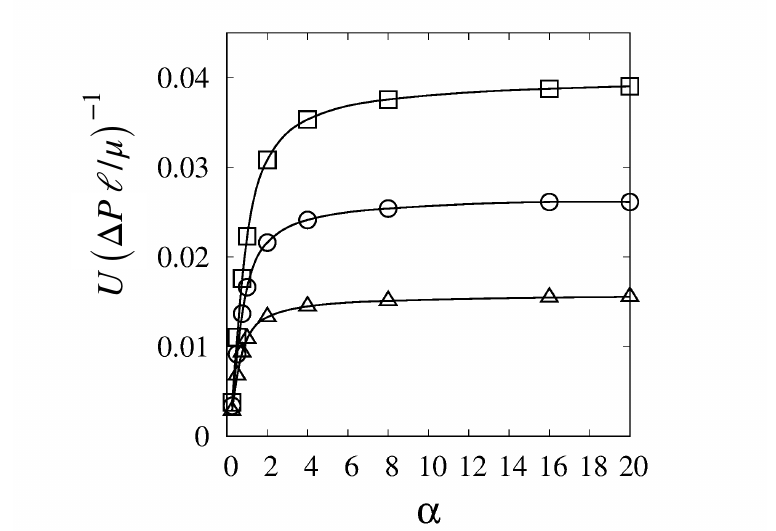
Figure 10. Dimensionless average velocity, vs the cell aspect ratio for different values of the obstacle diameter, d o . Squares: d o = 0.8; circles: d o = 0.6; triangles: d o =